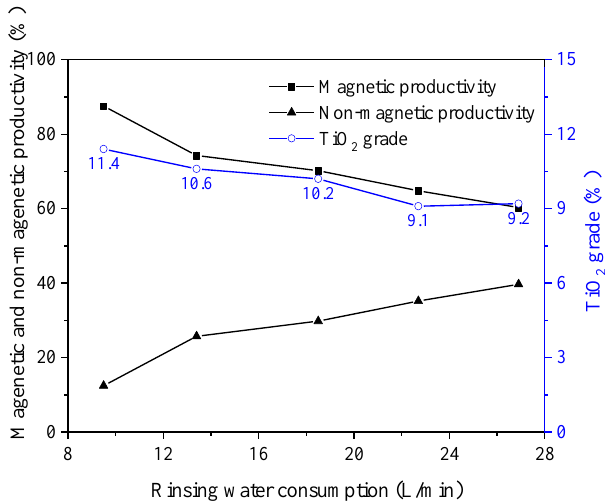
Figure 11. Effect of rinsing water consumption on separation performance at a magnetic induction of 1.0 T and a belt rotating speed of 2 r/min.